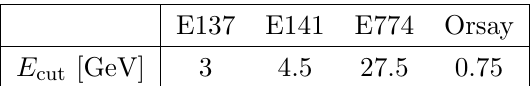
Table 2 . Cuts on the minimum event energy used in the analyses of E137 [21], E141 [20], E774 [22] and Orsay [23].